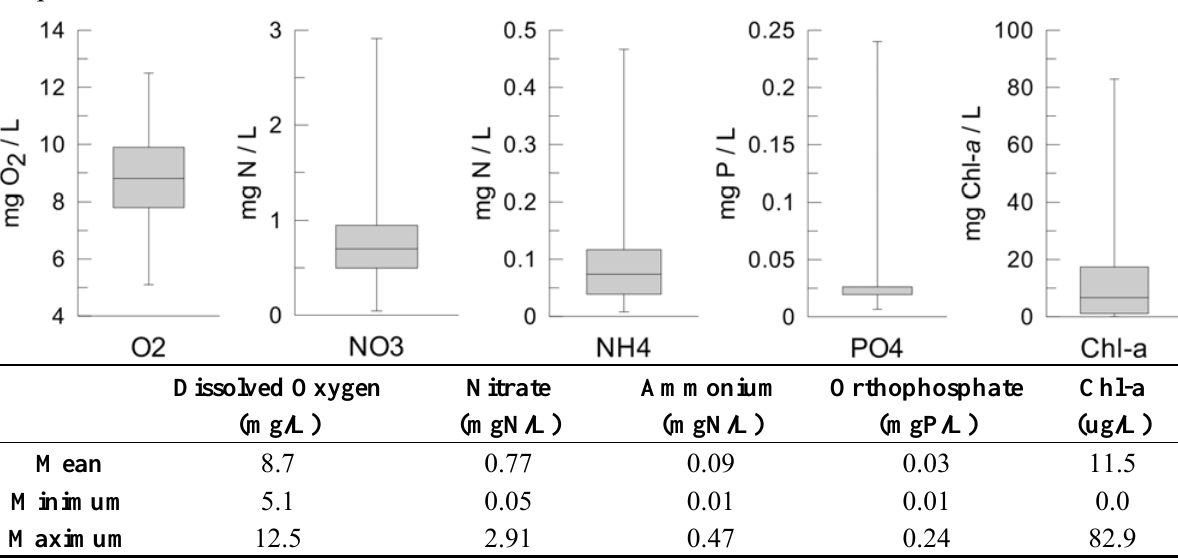
Table 1. Description of more relevant water quality parameters at the surface in the Torrão reservoir. Boxplots provide additional information on the frequency of variation for each parameter. Data from 1996 to